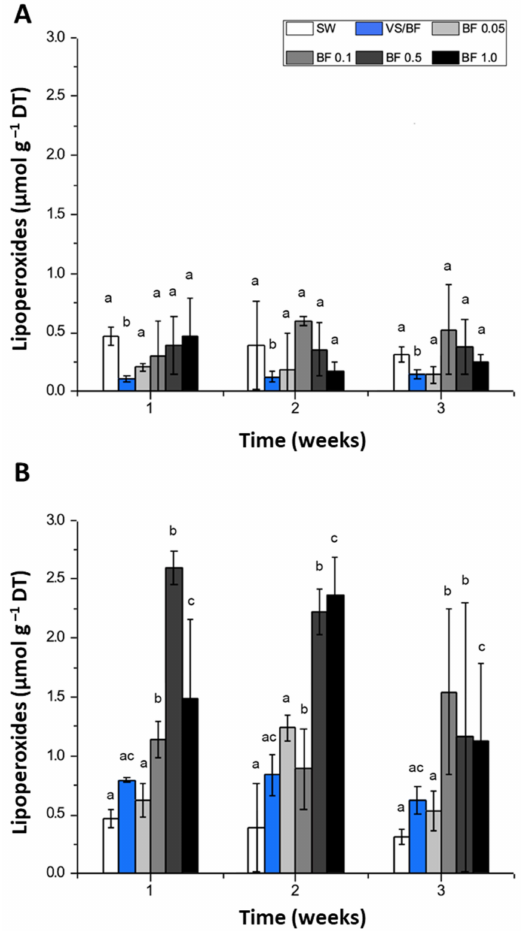
Figure 3. Lipoperoxide concentration ( µ mol g –1 DT, dry tissue) in G. chilensis obtained under ( A ) indoor and ( B ) outdoor cultivation systems for each treatment evaluated (seawater (SW) control, Von Stosch/Basfoliar ® Aktiv (VS/BF) treatment, and Basfoliar ® Aktiv (0.05%, 0.1%, 0.5%, and 1% v / v ) treatments) during the three weeks of the experimental period. Values are the mean ± SD of three replicates. The letters above the bar plots indicate the results of Dunn ´ s tests; means with the same letter are not significantly different at p ≥